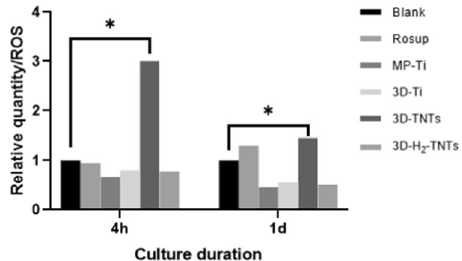
Fig. 9 Intracellular ROS. Flow cytometry detection of the intracellular ROS of HGFs cultured on the four groups of samples for 4 h and 1 day with statistical signi fi cance at * p <